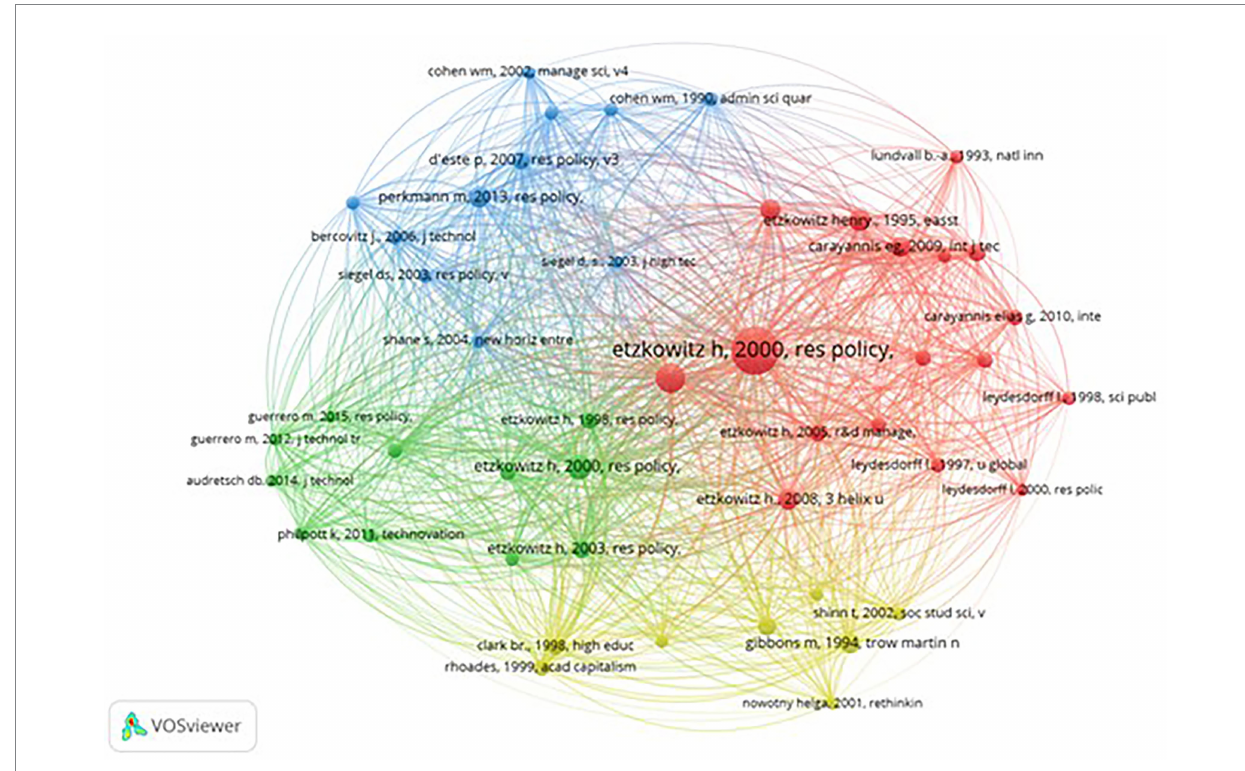
FIGURE 3 Co-citation analysis of the Helix Model and Education.